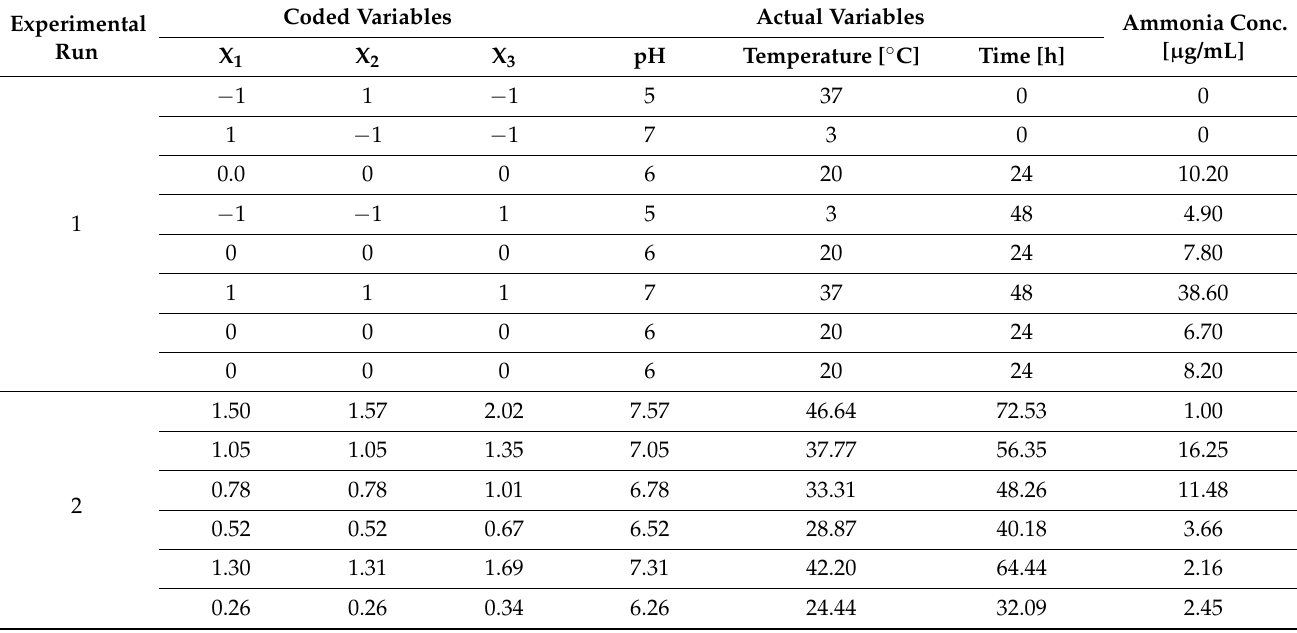
Table 4. The summary of response surface methodology carried out against Lactobacillus acidophilus LA-5 to examine its abil- ity to produce ammonia in the presence of acrylamide. The table present Box-Behnken design matrix and response values. Coded Experimental Run